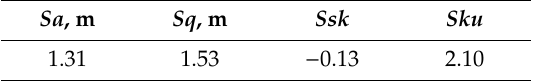
Table 3. Selected surface roughness parameters of sheet tested.